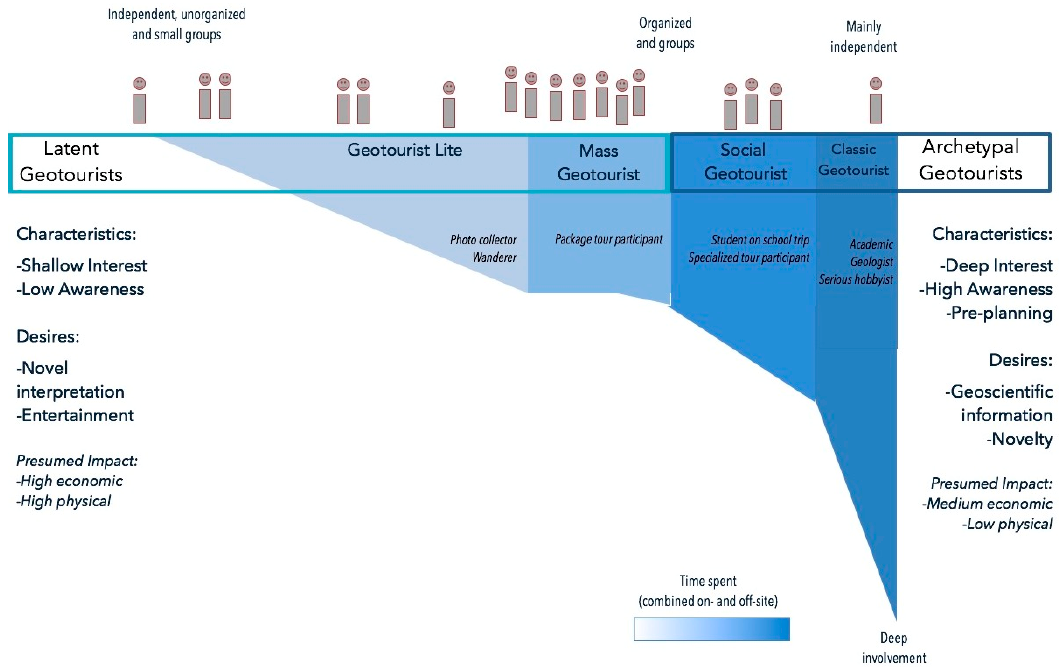
Figure 3. In the conceptual typology, latent geotourists populate the left and archetypal geotourists the right. Characteristics, desires, and presumed impact were factors gleaned from the literature.